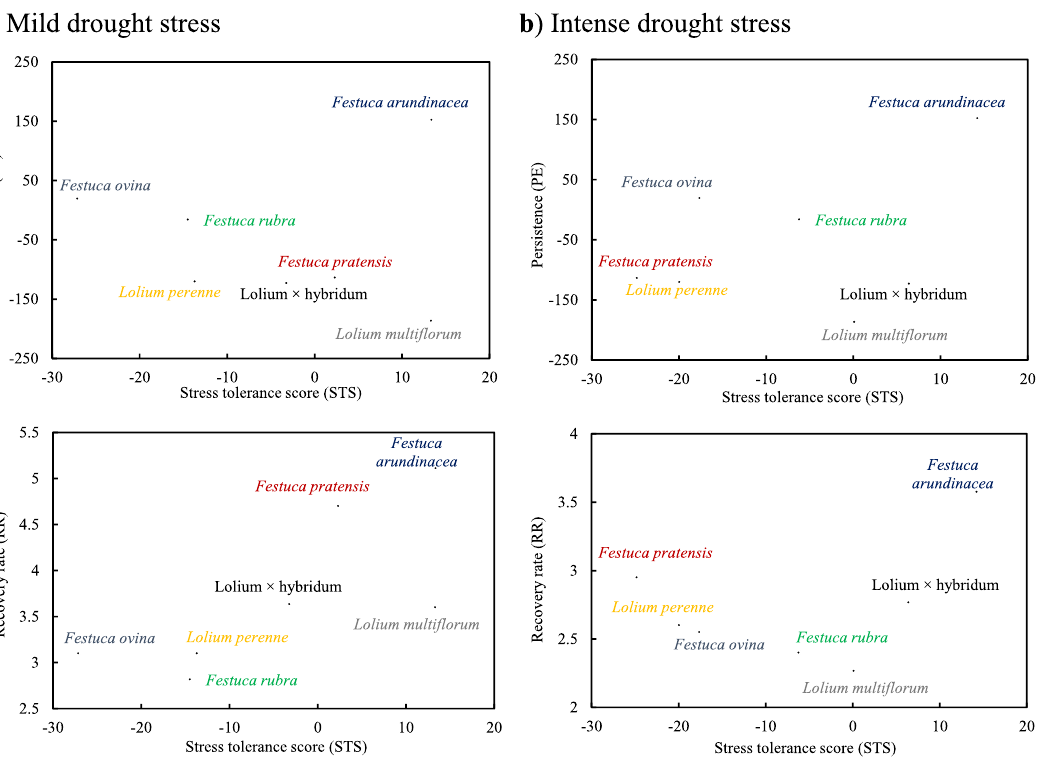
Figure 2. Biplot of stress tolerance score (STS) vs. persistence (PE) and recovery rate (RR) for seven grass species under two drought stress levels (mild and intense drought